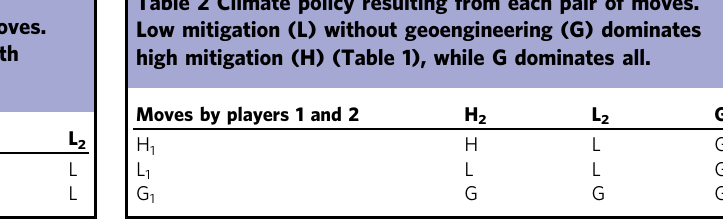
Table 2 Climate policy resulting from each pair of